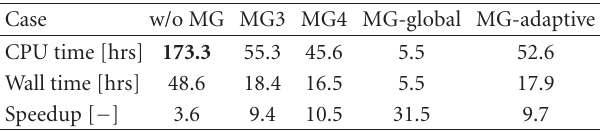
Table 2: Computational time of one-zone MG model with di ff erent searching levels (CA = − 6 . 3 to 70).